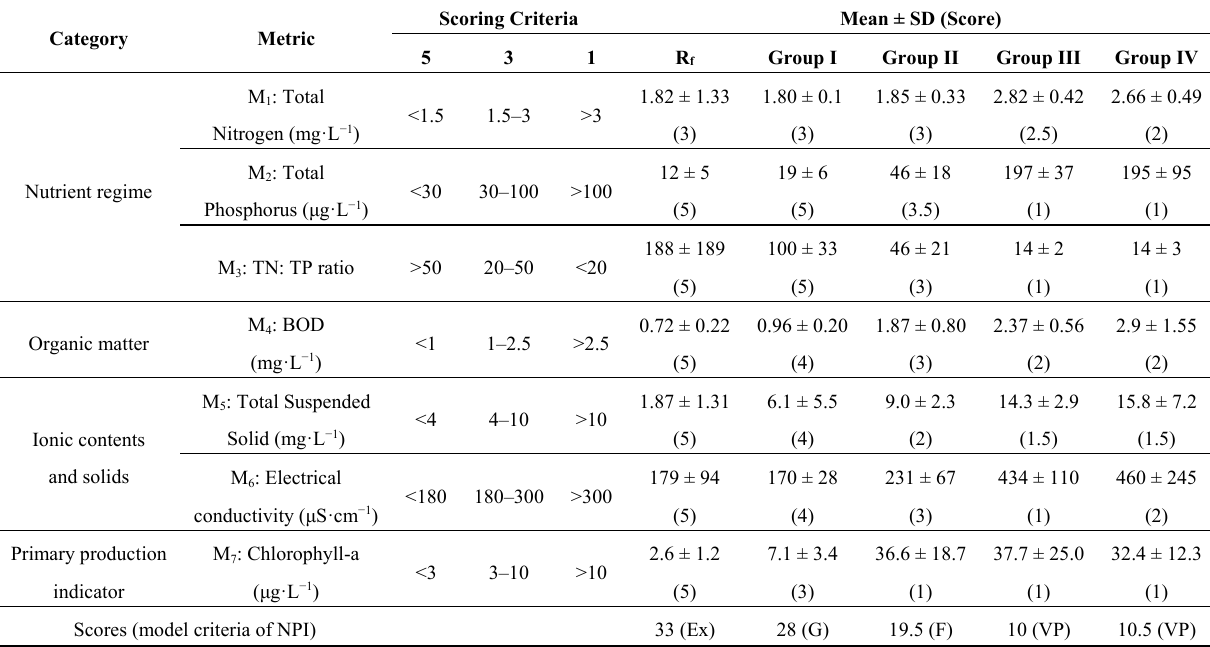
Table 2. Chemical health assessment model, based on the Nutrient Pollution Index (NPI), suggested scoring criteria and evaluated score in the watershed of Nakdong